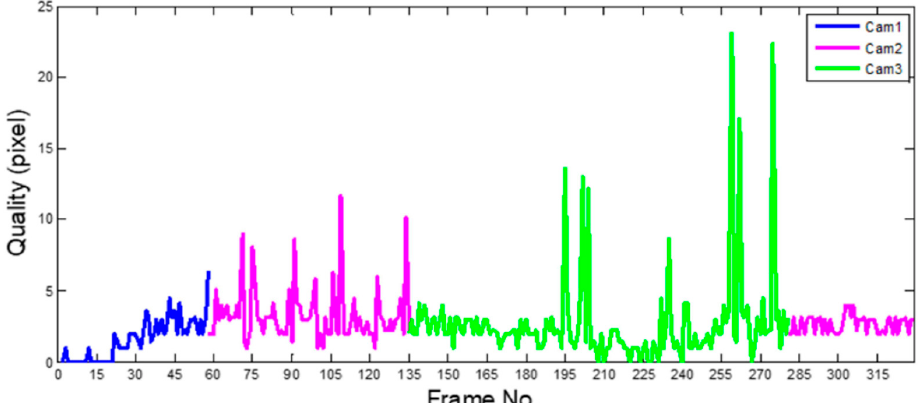
Figure 11. Evaluate single person tracking using MS metrics.